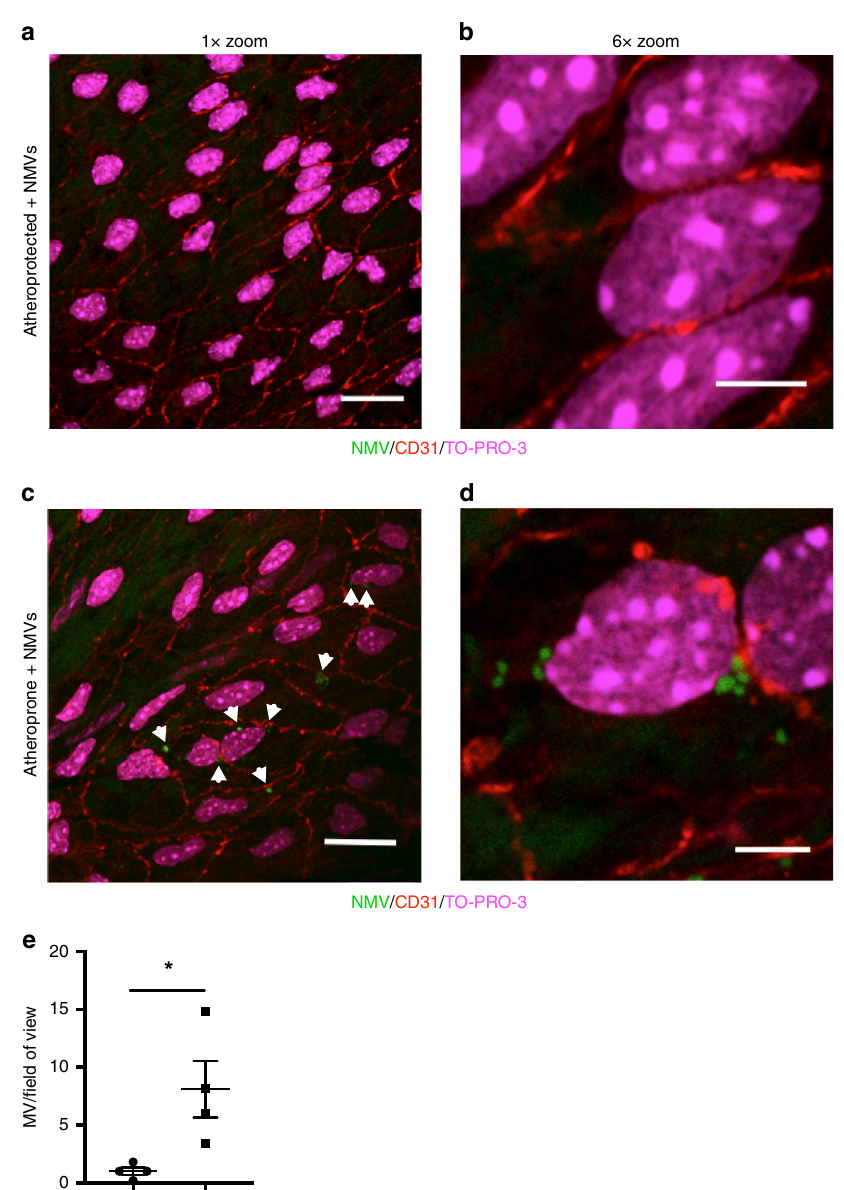
Fig. 2 NMVs preferentially adhere to atheroprone regions in vivo. Fluorescently labelled NMVs (green) were injected via the tail vein into ApoE − / − mice that had been fed a Western diet for 6 weeks. After 2 h, mice were culled and en face immunostaining of the mouse aortic arch was performed. Representative en face images of NMV adhesion in atheroprotected (outer curvature, a , b ) and atheroprone (inner curvature c , d ) regions of the aorta, visualised by confocal fl uorescence microscopy. Endothelial cells were identi fi ed by staining with anti-CD31 antibody (red) and cell nuclei were identi fi ed using TO-PRO Iodide (magenta). Outer and inner curvature of the ascending aorta were identi fi ed by anatomical landmarks and con fi rmed by characterising the phenotype of endothelial cells; those at the outer curvature were aligned, elongated and uniform — a characteristic of cells under high shear, whereas cells in the inner curvature had a disorganised appearance. Samples were visualised using a ×100 objective at ×1 zoom ( a , c ) and at ×6 zoom ( b , d ). Scale bars = 20 µ m ( a , c ), 5 µ m ( b , d ). e Quanti fi cation of adherent NMVs presented as mean ± SEM ( n = 4 animals) and statistical signi fi cance evaluated using a paired t -test test. * P < 0.05. Source data are provided as a Source Data fi